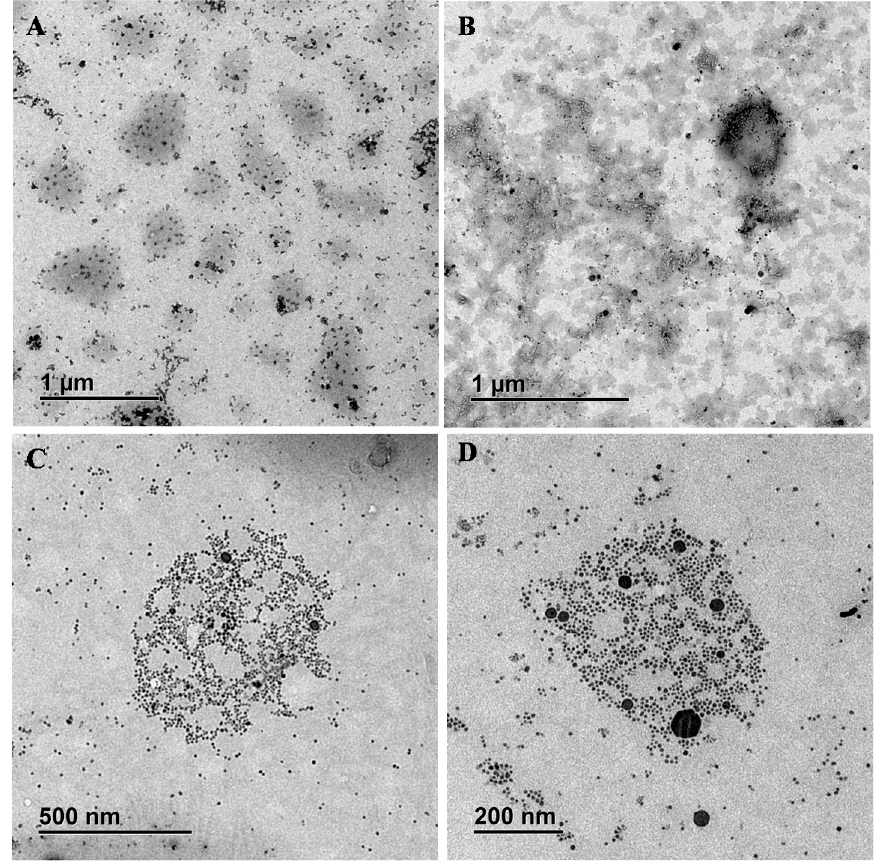
Figure 4. TEM images for hybrid PLGA@Ag 2 S_R1 particles performed at ( A ) 0 h, ( B ) 8 h, ( C ) 24 h, and ( D ) 48 h.